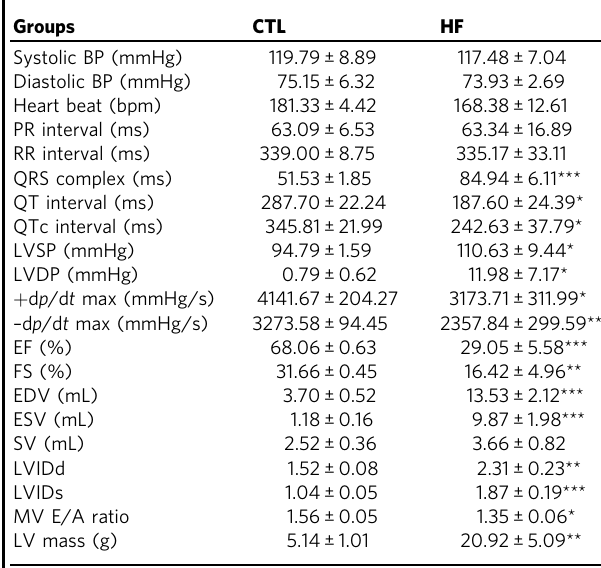
Table 1 Comparison of cardiac functions parameters of